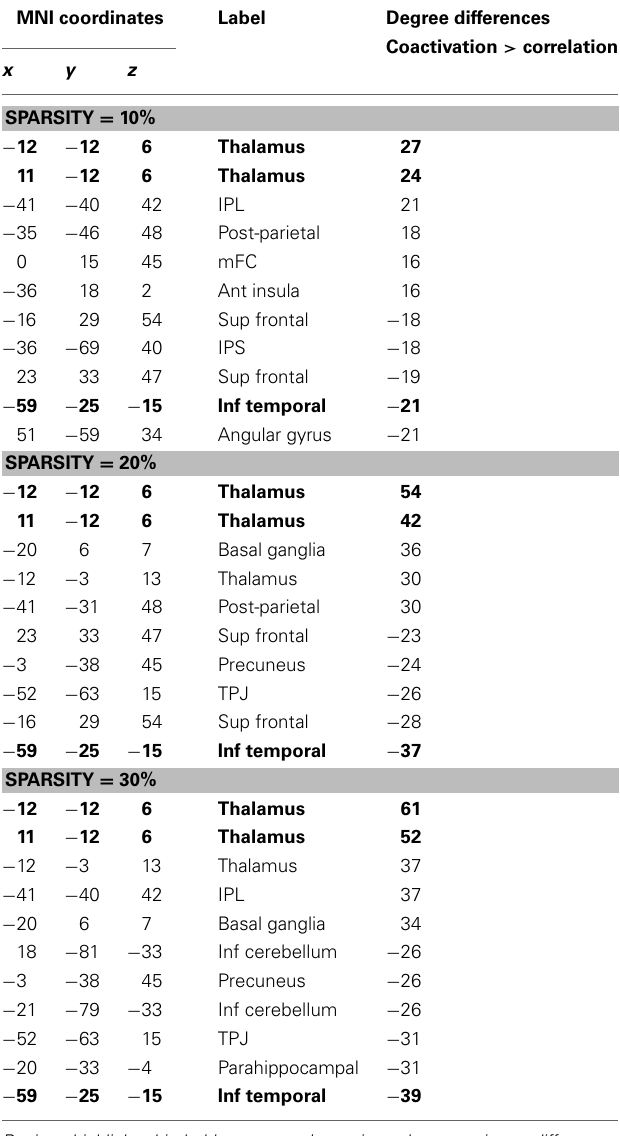
Regions highlighted in bold represent the regions show consistent differences between the two networks across the three sparsity